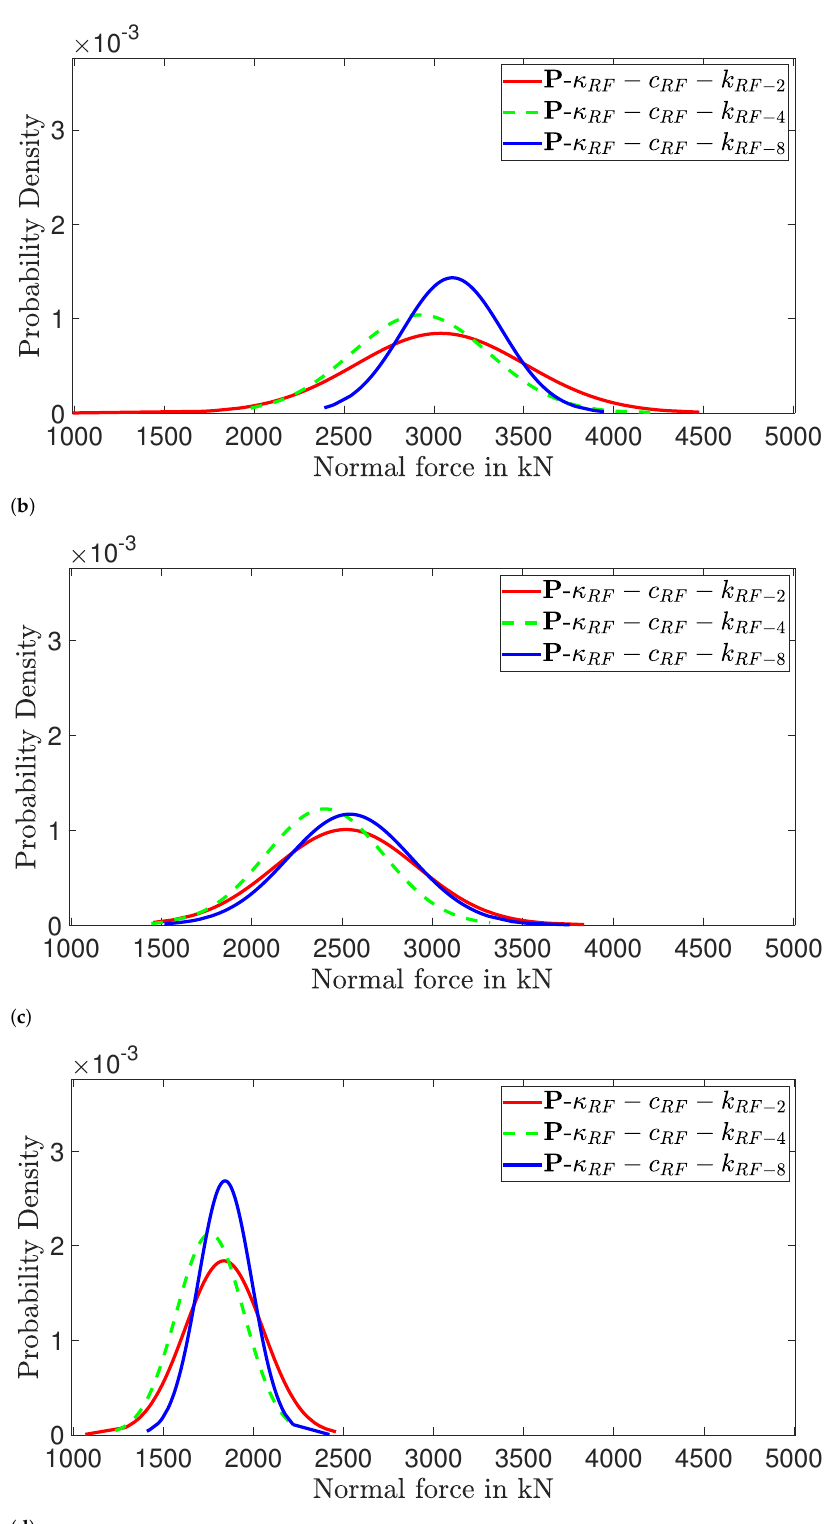
Figure A5. PDFs of the Normal force of the settlement in kN for porous analyses with random field representation for the stochastic material variables. κ RF , κ RF , κ RF stands for correlation length b = 2, 2 8 4 4, 8 for κ respectively whilst c RF , c RF , c RF stands for correlation length b = 2, 4, 8 for c respectively 2 8 4 and k RF , k RF , k RF stands for correlation length b = 2, 4, 8 for k. Subplot ( a – d ) stand for eccentricity 2 8 4 0, h , h , h , 6 3 12